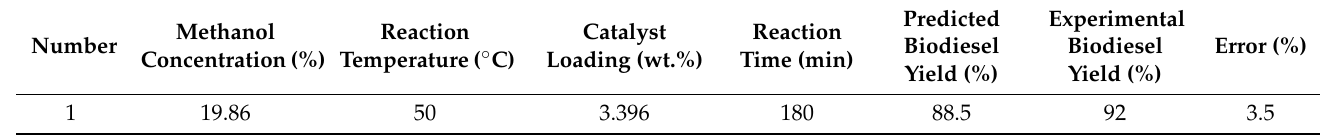
Table 8. The model evaluation at the optimized conditions.